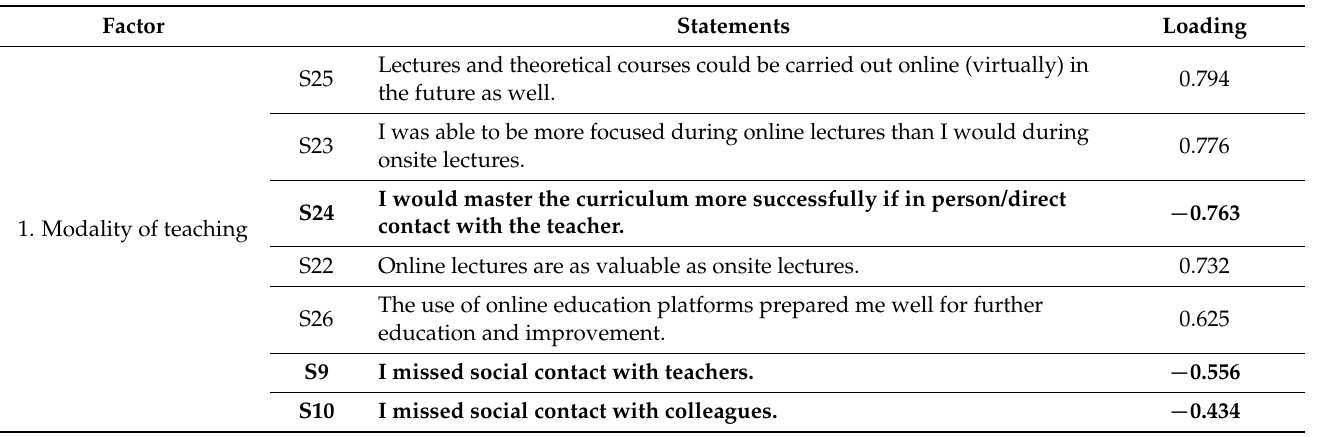
Table 5. Perceptions and attitudes toward SARS-CoV-2, teaching, and online teaching during COVID-19 pandemic grouped in dimensions by explanatory factor analysis.